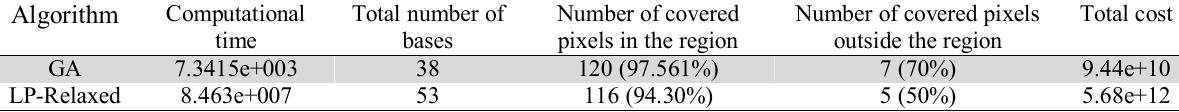
helicopter logistics in disaster relief operations. European Journal of